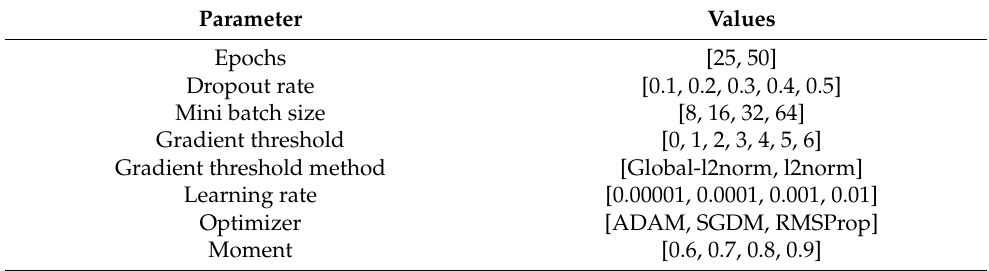
Table 1. The list of hyperparameter options for training combined CNN-LSTM deep learning